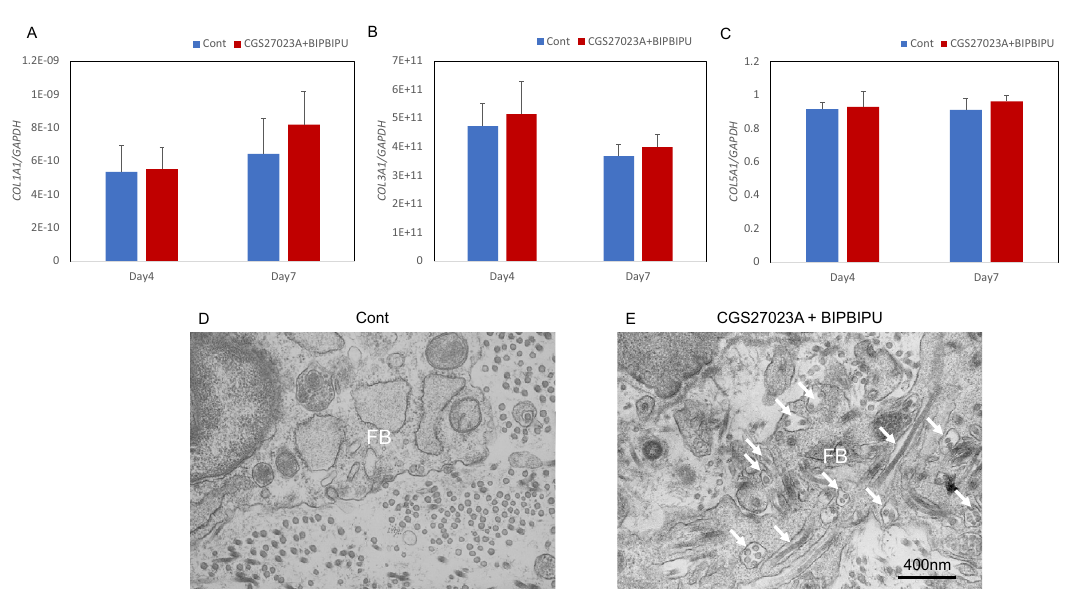
Figure 3. Effect of MMP inhibitor and heparinase inhibitor on collagen expression in the skin equivalent model. Immunostaining of type I procollagen ( A–D ), type I collagen ( E–H ), type III collagen ( I–L ) and type V collagen ( M–P ) in the skin equivalent model in presence of MMP inhibitor CGS27023A ( B, F, J, N ), heparinase inhibitor BIPBIPU ( C, G, K, O ), or both MMP inhibitor CGS27023A and heparinase inhibitor BIPBIPU ( D, H, L, P ) as compared with control ( A, E, I, M ). Staining signal intensities of type I procollagen ( Q ), type I collagen ( R ), type III collagen ( S ) and type V collagen ( T ) were analyzed using WINROOF 2015 image-analyzing software (Mitani, Fukui, Japan, https:// www. mitani- visual. jp/ produ cts/ image_ analys_ ismea sure- ment/ winro of/). Data are the means ± SD of three independent experiments. *p < 0.05, **p < 0.01. White bars: 100 μm.